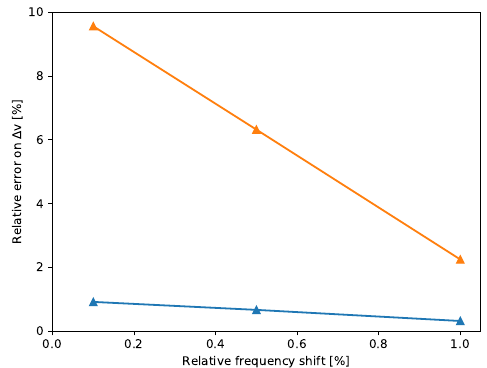
Figure 7. Relative error on ∆ ν when recovering frequency shifts from 0.1% to 1% using either 1 day (orange) or 1 week (blue) as current quantity.